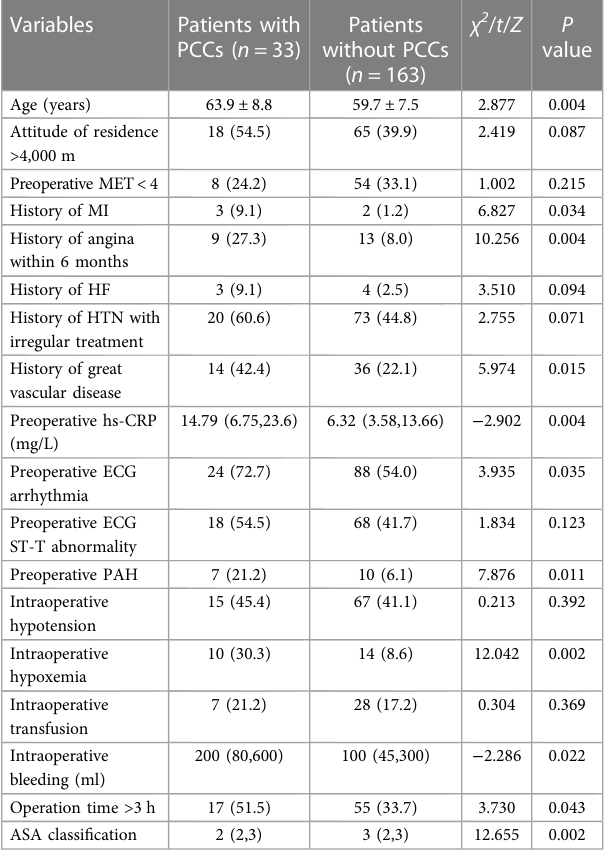
TABLE 3 Possible risk factors for PCCs in univariate